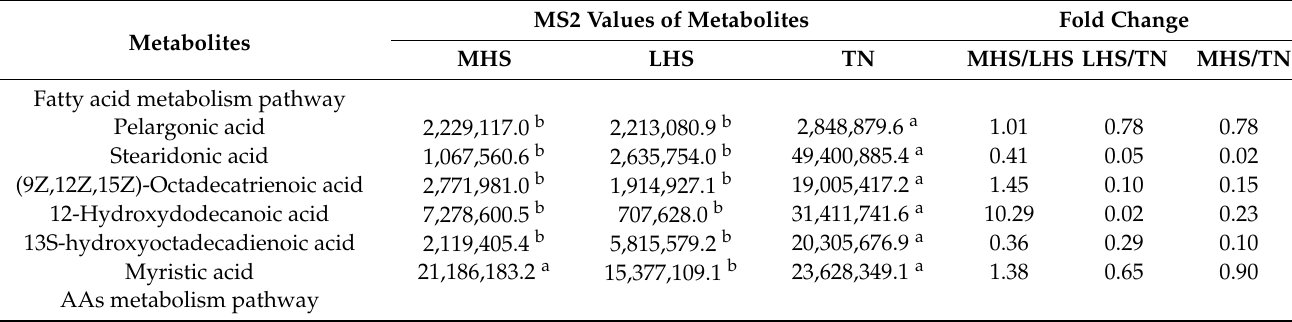
Table 4. Distinct plasma metabolites of fatty acids, amino acids, and